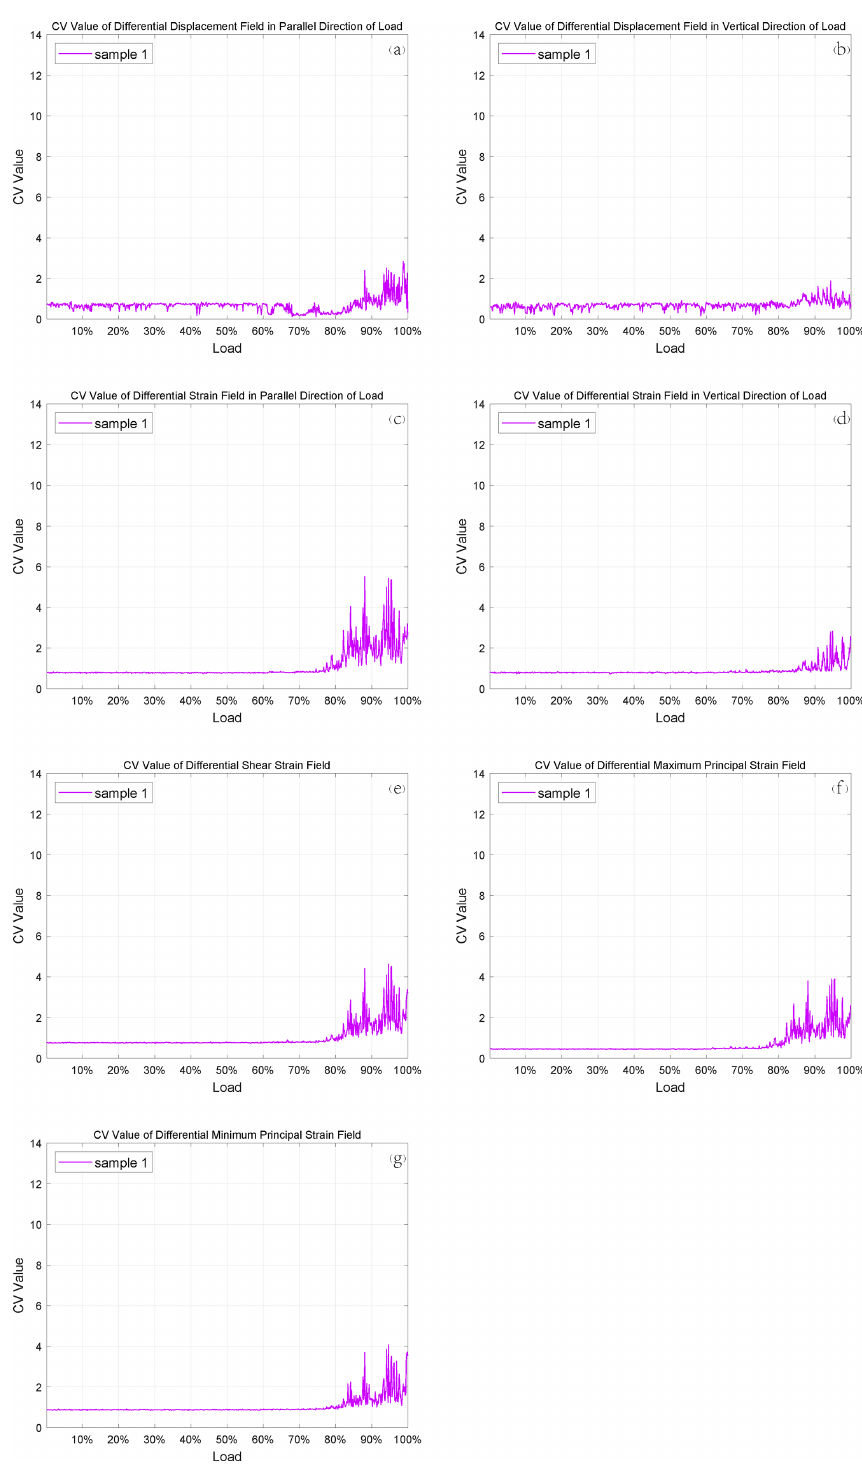
Figure A1. CV images of sample 1. Subfigures represent the CV of various physical